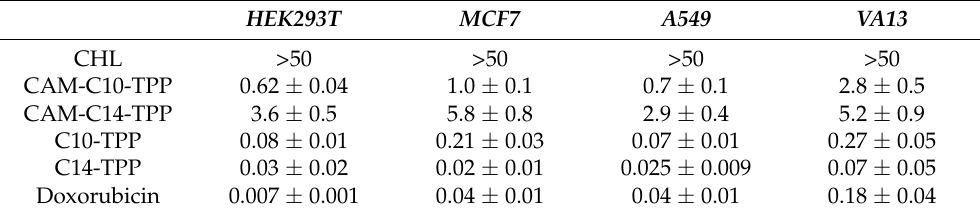
Table 3. Growth inhibition by CAM-Cn-TPPs in relation to a number of cell lines according to the MTT assay. Values of a 50% growth inhibition concentration (GI50, µ M) are